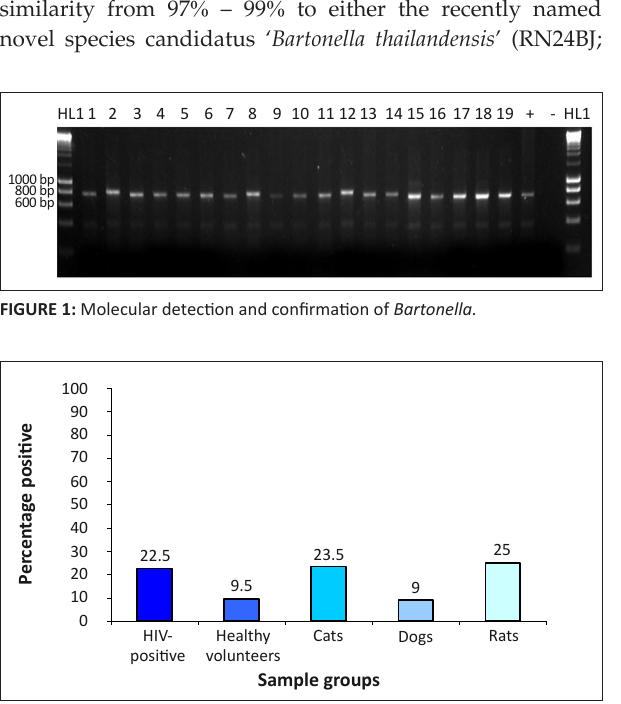
FIGURE 2: The positive percentage for the sample